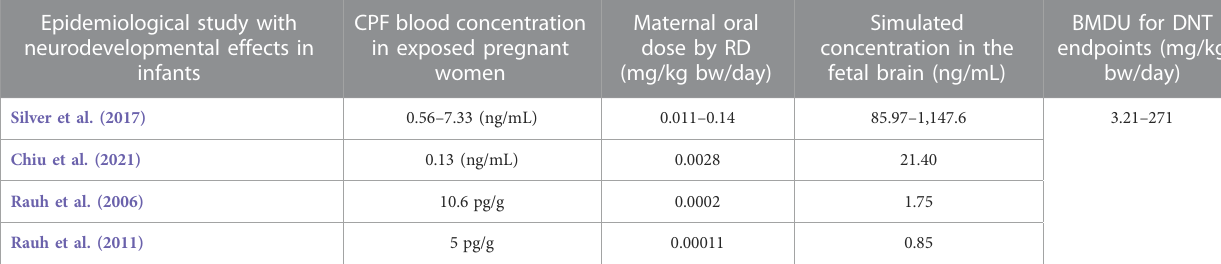
TABLE 4 PBK model-predicted oral maternal doses and CPF concentrations in fetal brain corresponding to reported CPF levels in epidemiological studies. Epidemiological study with neurodevelopmental effects in